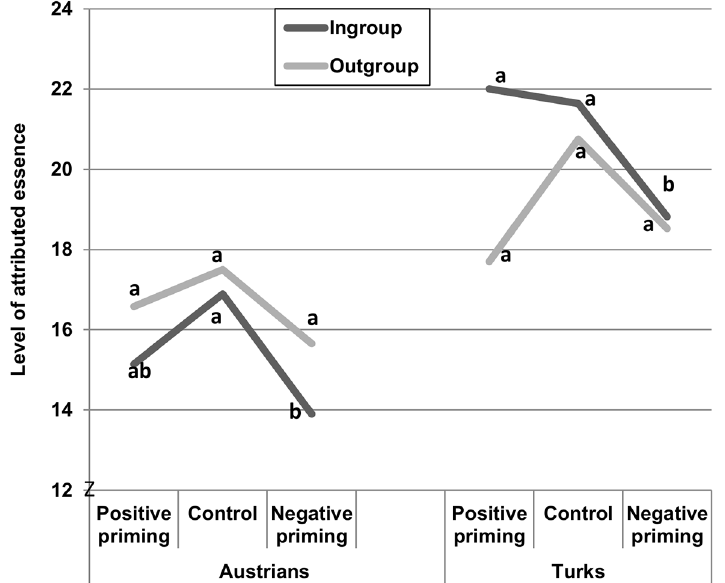
Figure 2. Degree of essentialist attribution by priming (positive vs neutral control vs negative), group status (Austrian majority vs. Turkish minority) and target (ingroup vs